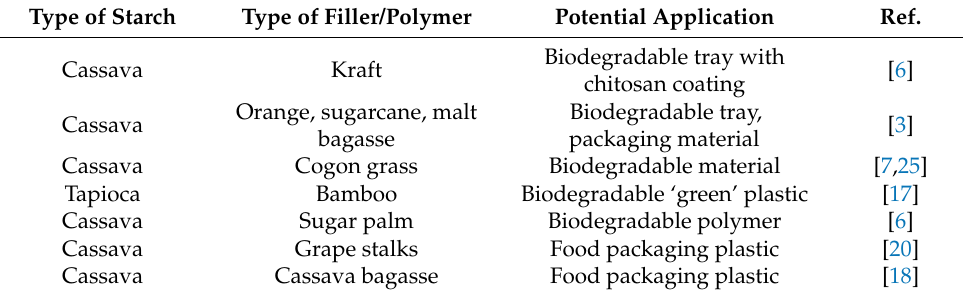
Table 1. Thermoplastic cassava starch